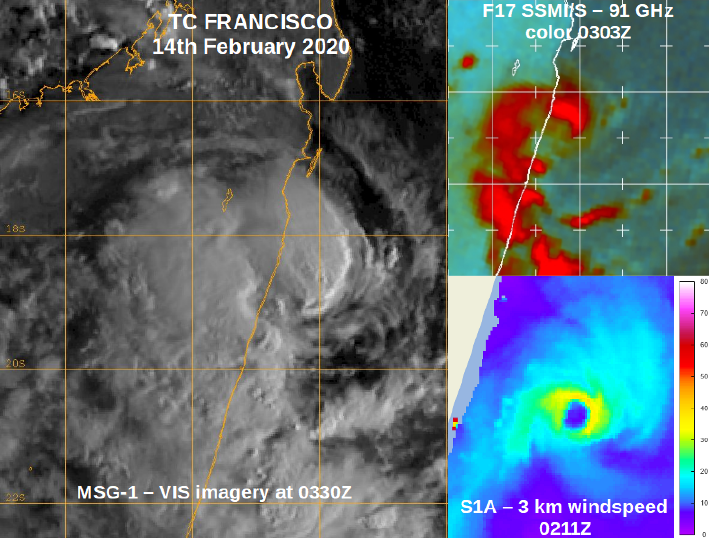
Figure 6. TC FRANCISCO, on the morning of 14 February, seen by MSG-1 VIS imagery and F17 SSMI/S 91 GHz color imagery (deep convection areas are seen in red) for the clouds organisation and by S1-A for the estimated surface wind field. Units for SAR imagery are m · s − 1 . VIS and microwave imagery courtesy from Naval Research Labotory/US Navy. SAR product obtained from Ifremer/Cyclobs and produced with SAR wind processor co-developped by IFREMER and